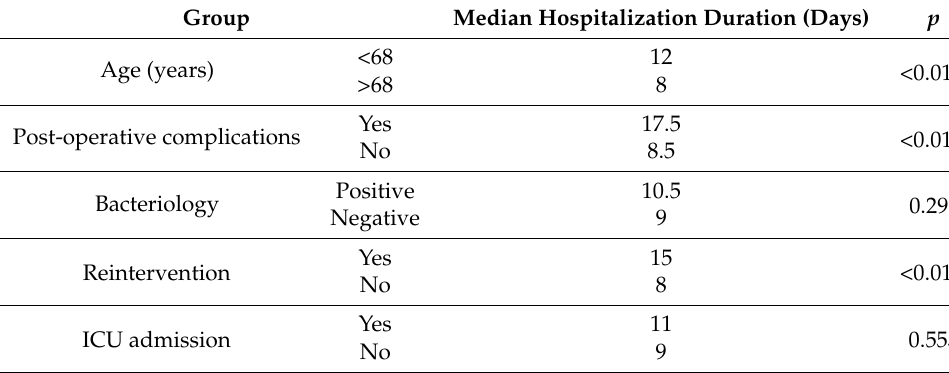
Table 3. Median hospitalization duration in days between different groups.